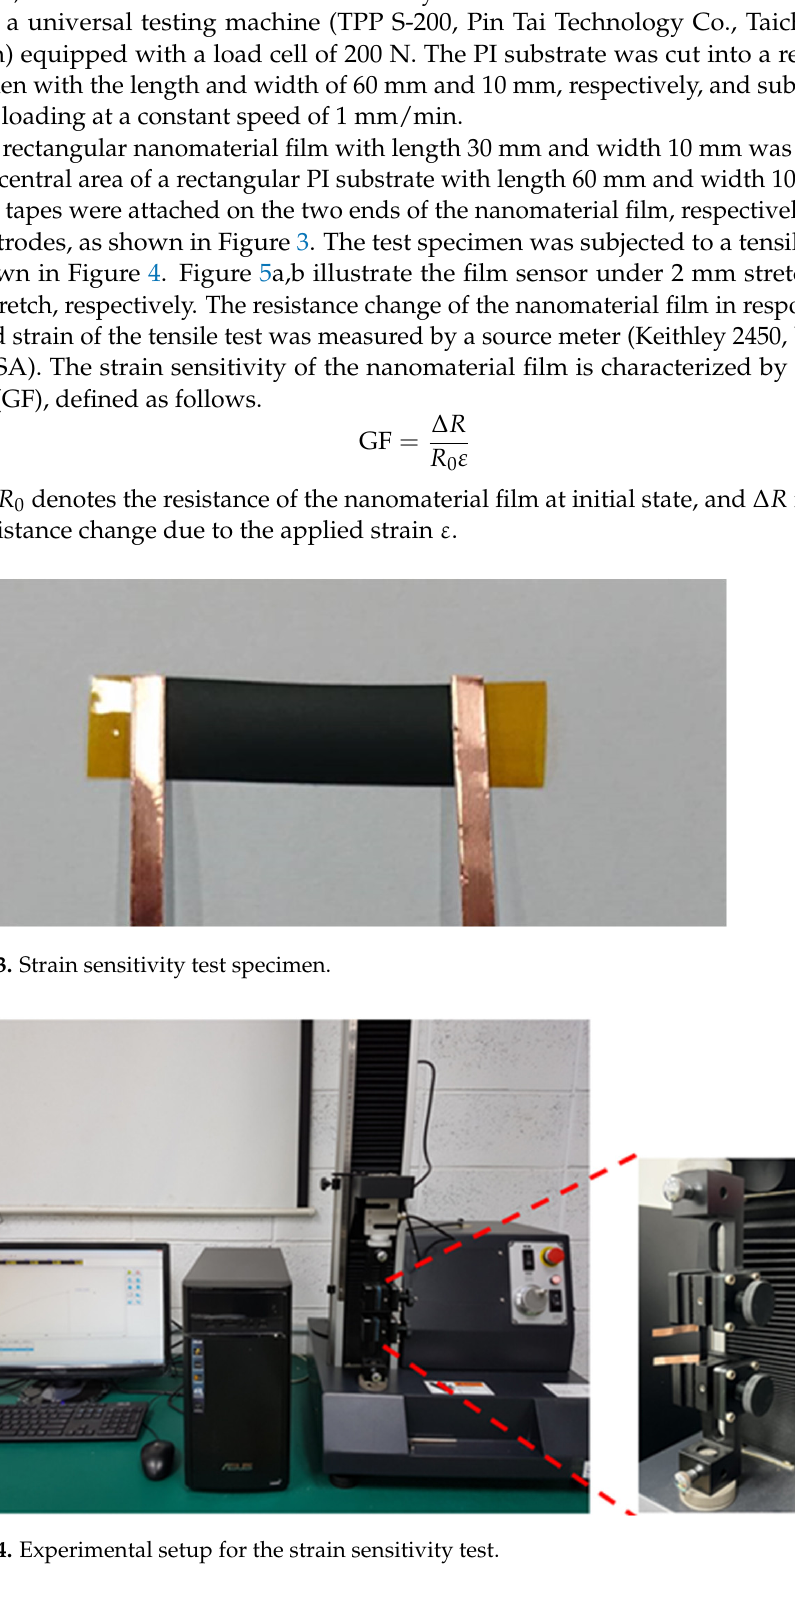
Figure 4. Experimental setup for the strain sensitivity test.